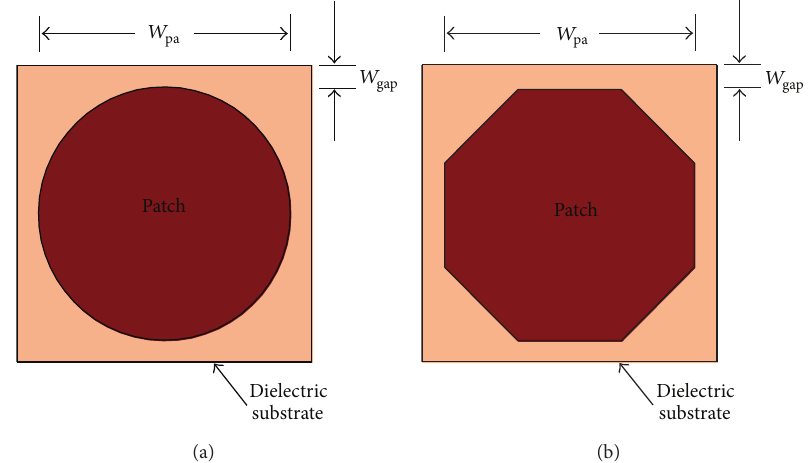
Figure 4: A unit cell of an AMC structure. (a) A circular patch. (b) An octagonal patch.